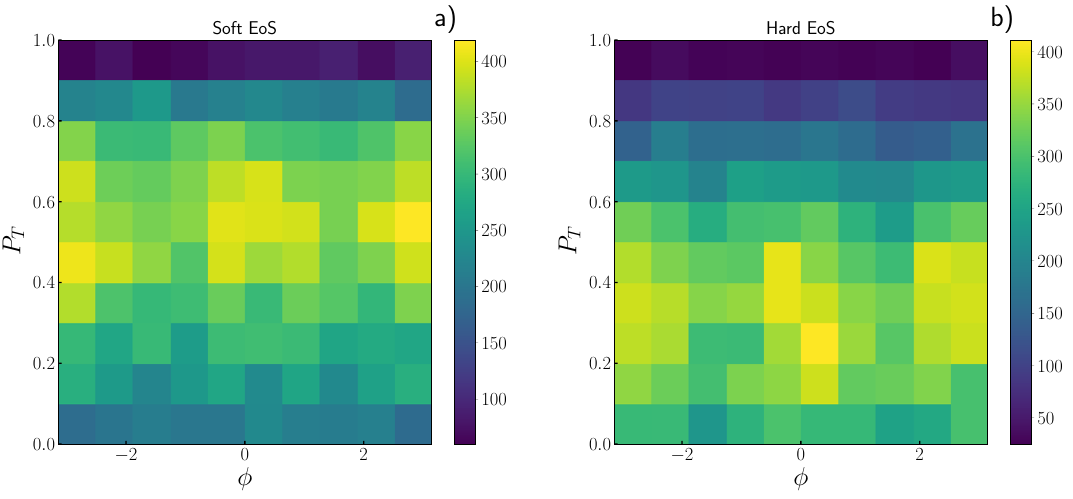
Figure 4 . The same as (cid:12)gure 3, but for 100 Au+Au collisions.